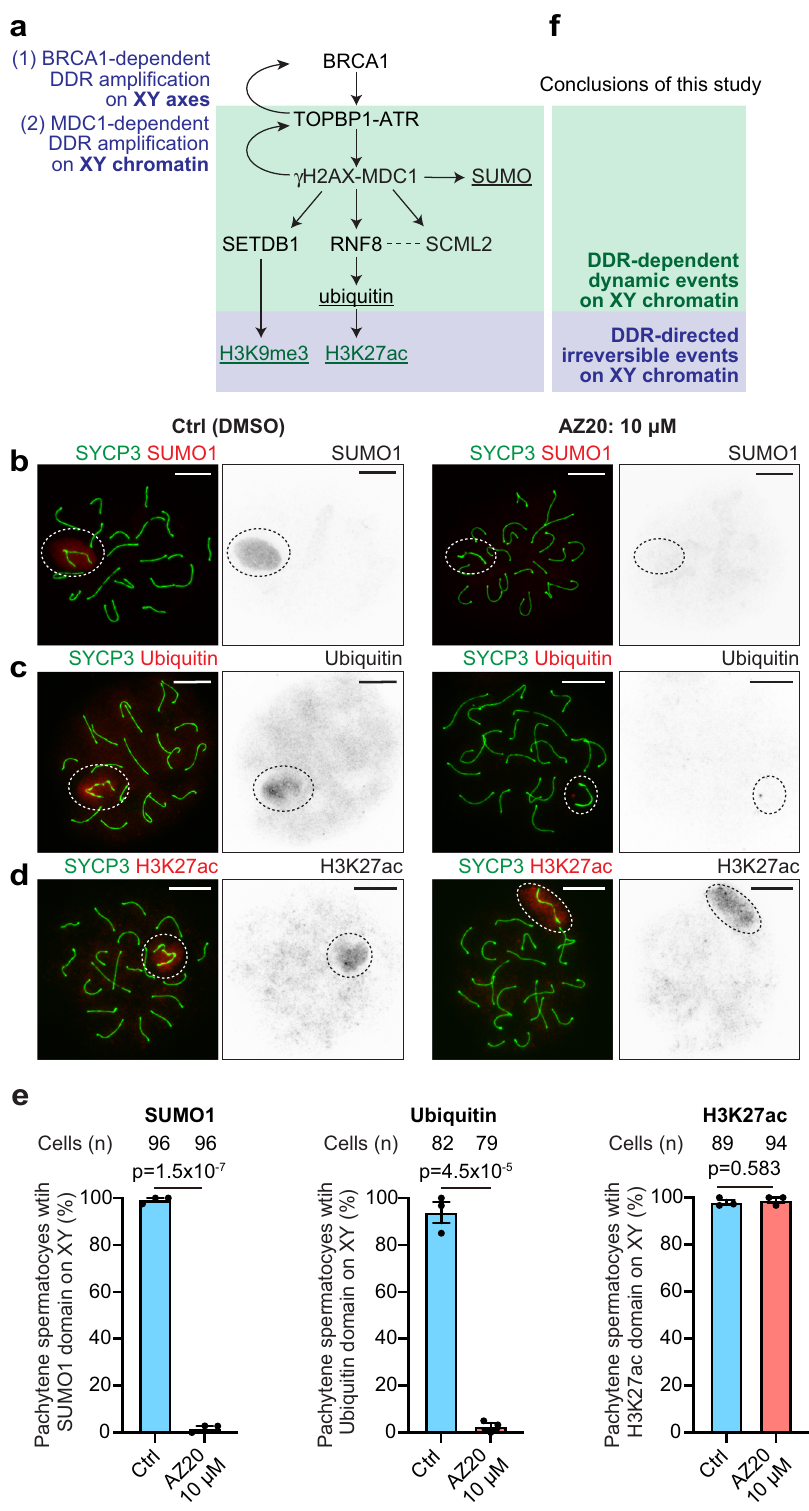
Fig. 6 | Both dynamic and irreversible epigenetic states are established on the XY chromatin in a manner dependent on ATR-mediated signaling during pachytene. a Schematic of the molecular pathways that establish various epige- netic states on the sex chromosomes. Post-translational modi fi cations are under- lined. b – d Chromosome spreads of mid-late pachytene spermatocytes